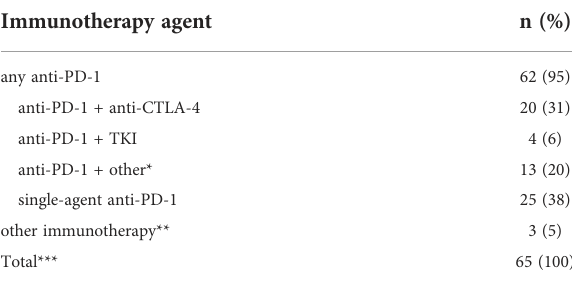
TABLE 3 Immunotherapy regimens.